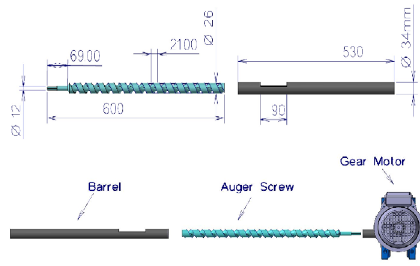
Fig. 10 Single spiral screw manufactured in a laboratory